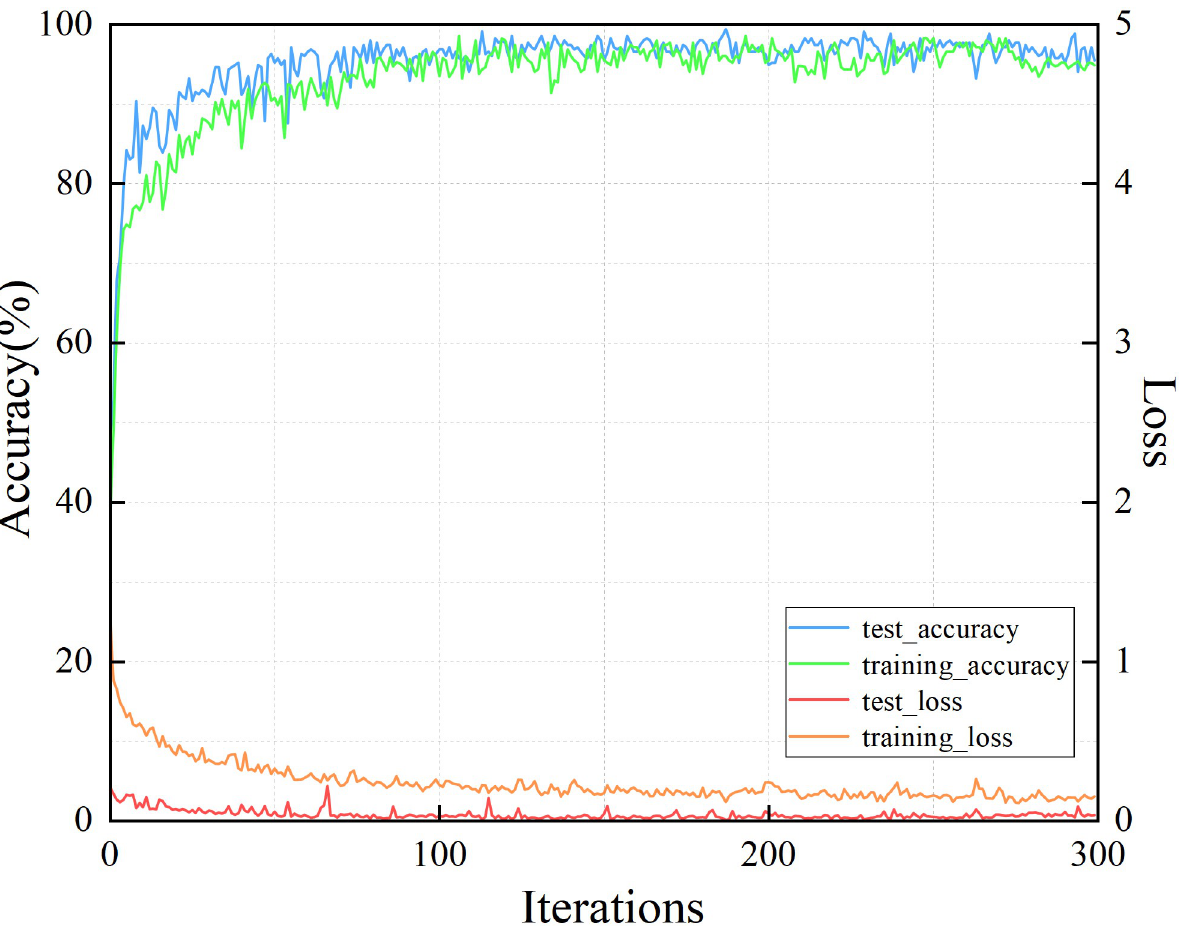
Fig 9. The comparison of several